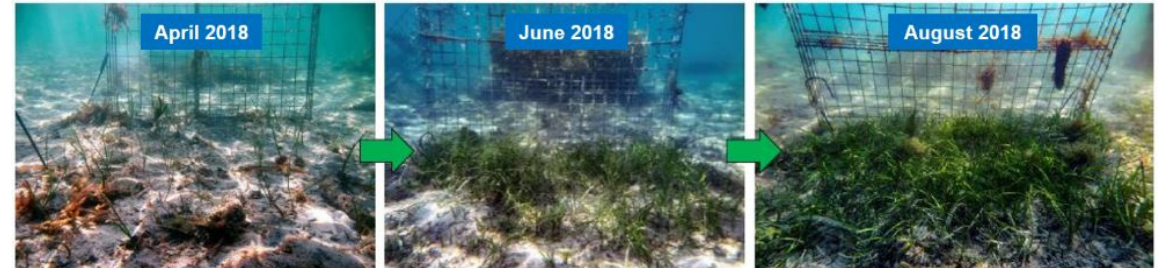
Figure 9. Transplantation of Cymodocea nodosa cuttings in Le Brusc Lagoon (eastern Provence). A wire cage preserves cuttings from Sarpa salpa grazing. For the purposes of photography and monitoring, the cage was raised vertically. From Couvray et al. [106]. © IOPR (Institut Océanographique Paul Ricard), courtesy of the authors.